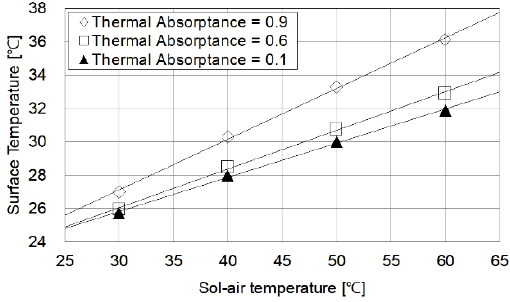
Figure 10. Sol-air temperature and surface temperature for the surface heat absorption rate of the wall.